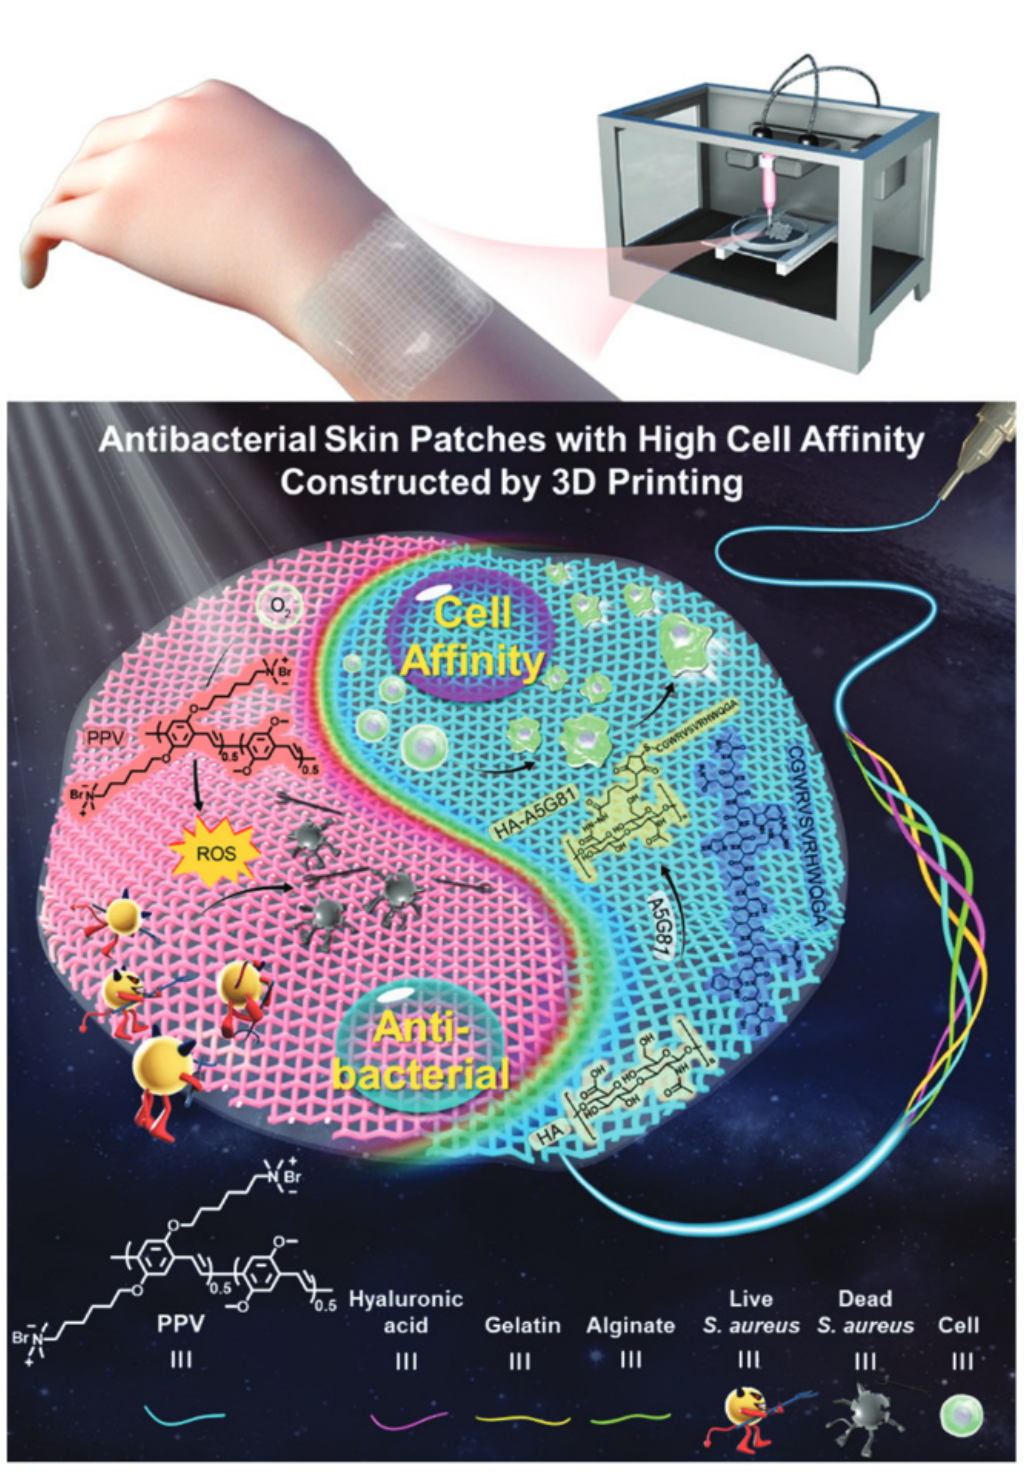
Figure 14. Illustration of 3D printed high-cell affinity enhanced antibacterial patch for wound repair based on conjugated polymer inks. Reproduced from Ref. [58] with permission from the Royal Society of